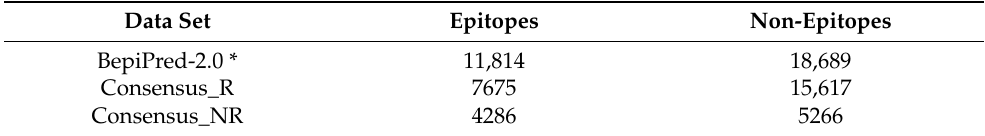
Table 5. A summary of test data sets utilized in this study. The counts of positive and negative subsets of data used in each of the three data sets developed for method testing is